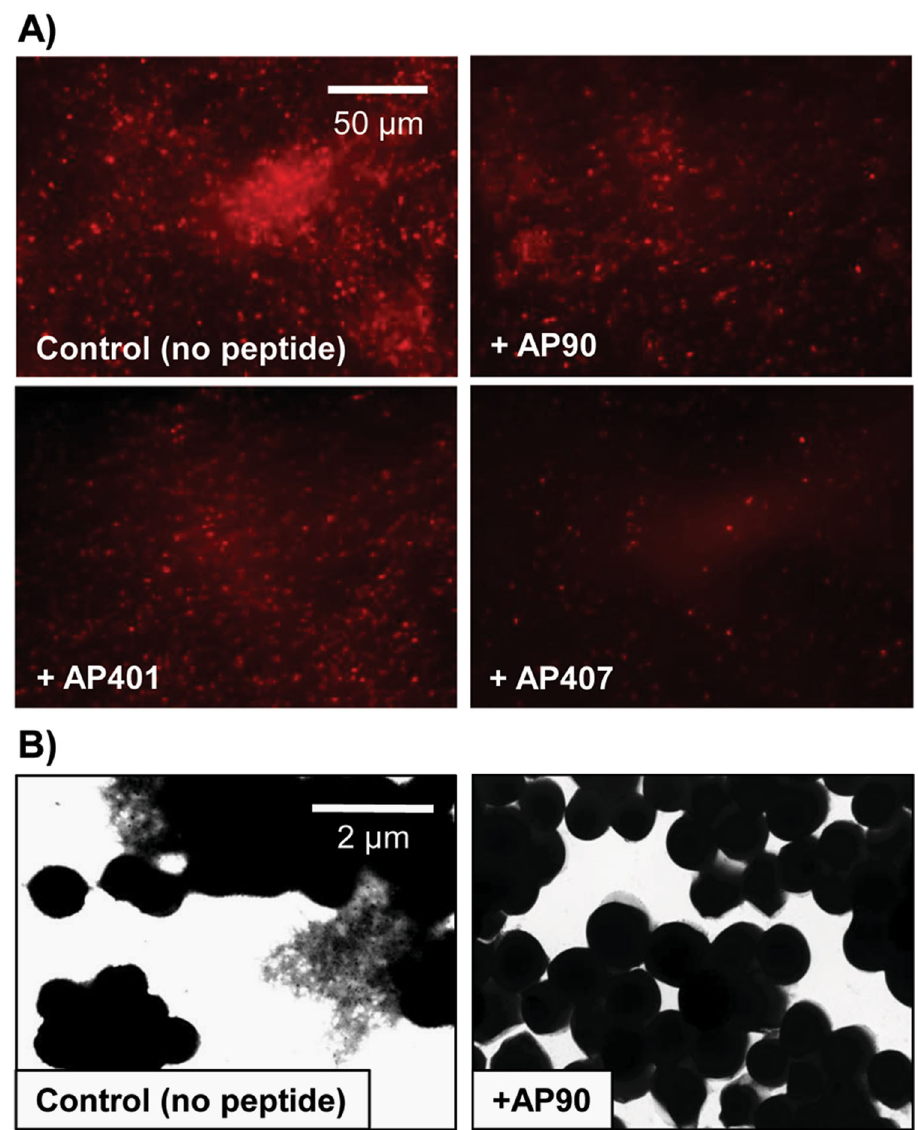
Fig. 2 S. aureus bio fi lm structures become less robust when grown in the presence of designed peptide inhibitors. a S. aureus MN8 + mCherry bio fi lms were grown on glass substrates for 24 h and then cells were washed and fi xed. The peptide inhibitors (80 μ M) caused cells to detach during the wash step. Images are representative of triplicate wells. For quanti fi cation of the images see Supplementary Fig. S2. b In S. aureus SH1000 WT bio fi lms grown in regular LB medium, PSM amyloid fi brils were visible as deposits in spaces between cells ( left ). Upon addition of the designed peptide AP90 (80 μ M), no extracellular fi bril deposits were observed ( right